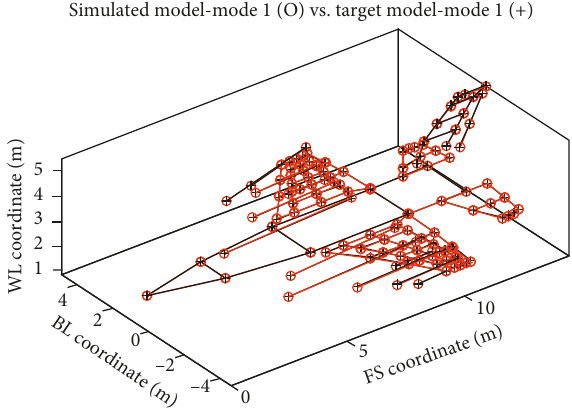
Figure 13: Mode shape for configuration 3 mode-1.